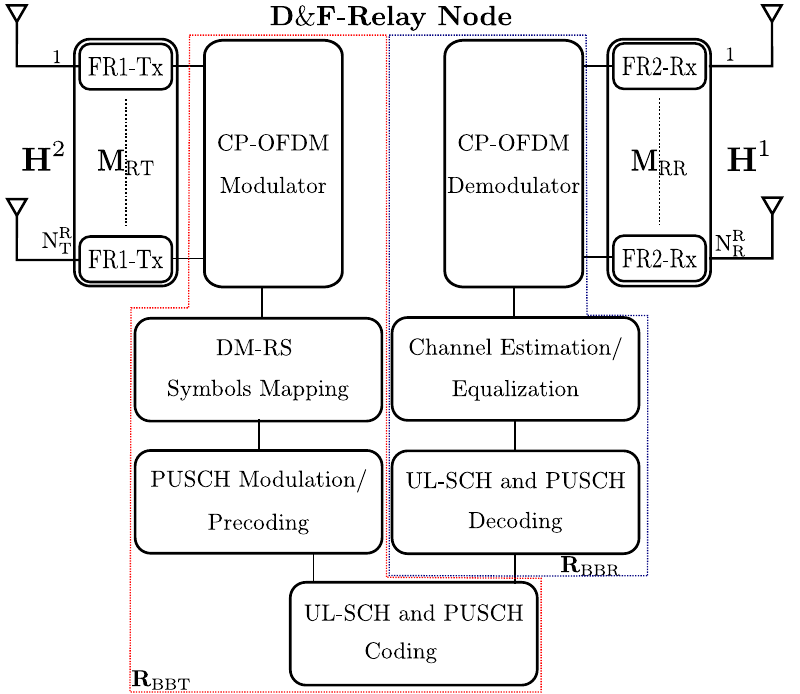
Figure 4. Uplink mmWave MIMO new radio decode-and-forward relay node